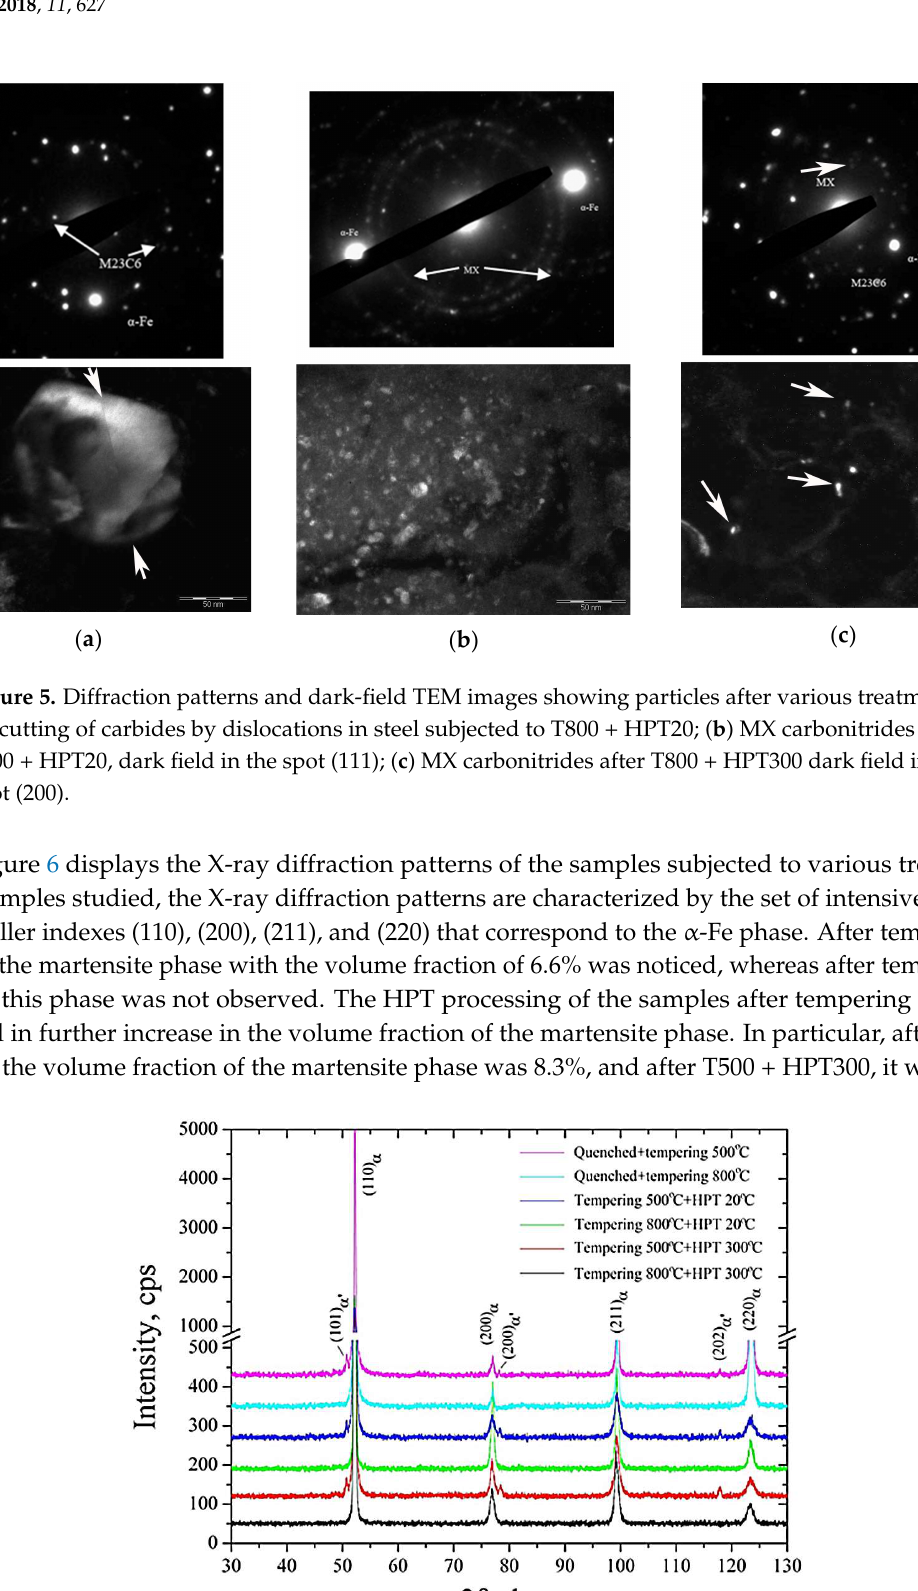
( c ) Figure 4. Diffraction patterns and dark-field TEM images showing carbides after various treatments: ( a ) T500, dark field in the spot (121) M 3 C; ( b ) T500 + HPT20, dark field in the spot (420)M 23 C 6 ; ( c ) T500 + HPT300, dark field in the spot (420)M 23 C 6 . After the T800 treatment, coarse particles of carbides of ~100–300 nm were observed in the microstructure. The carbides were located mainly at grain boundaries, and dispersed particles of fine secondary MX (М—V, Nb, Ti, Mo; Х—С, N) carbonitrides with an average size of ~50 nm were found at grain boundaries and at prior austenite boundaries (Figure 3b). The T800 + HPT20